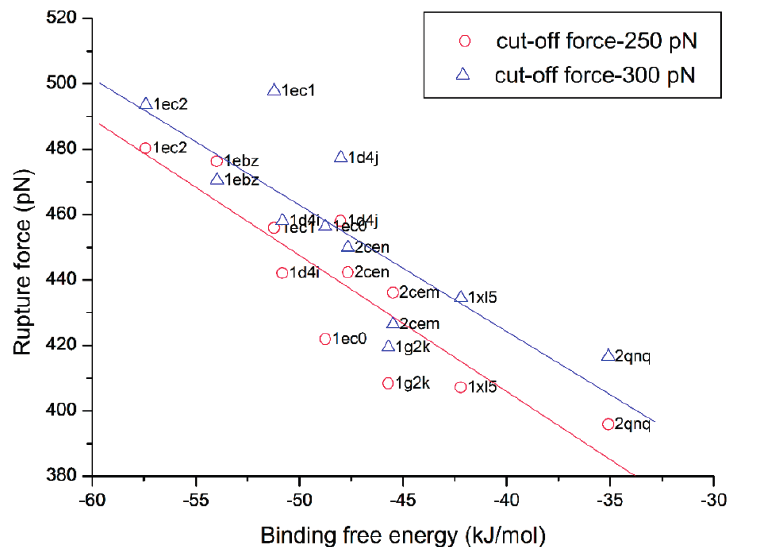
Figure 3. The influence of the cut-off force on the rupture force of the complexes in the HIV-1 protease family.